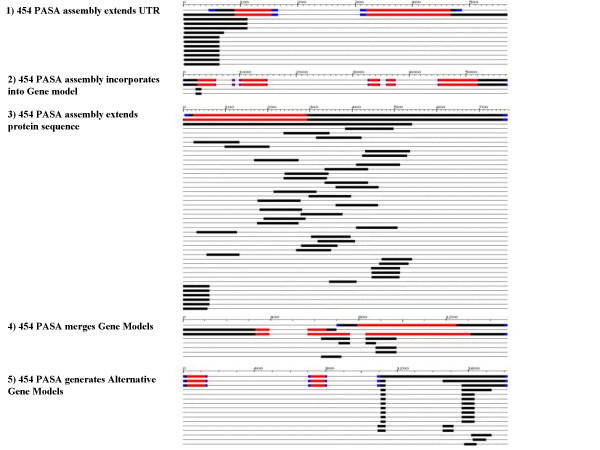
Examples of annotation updates and alignment assemblies. The protein coding segments of gene structures (top track) are shown in red and UTRs are shown in black. Alignment of 454 sequences are shown in black below the gene models. Boundaries consistent with the original gene structure annotation are highlighted in blue.